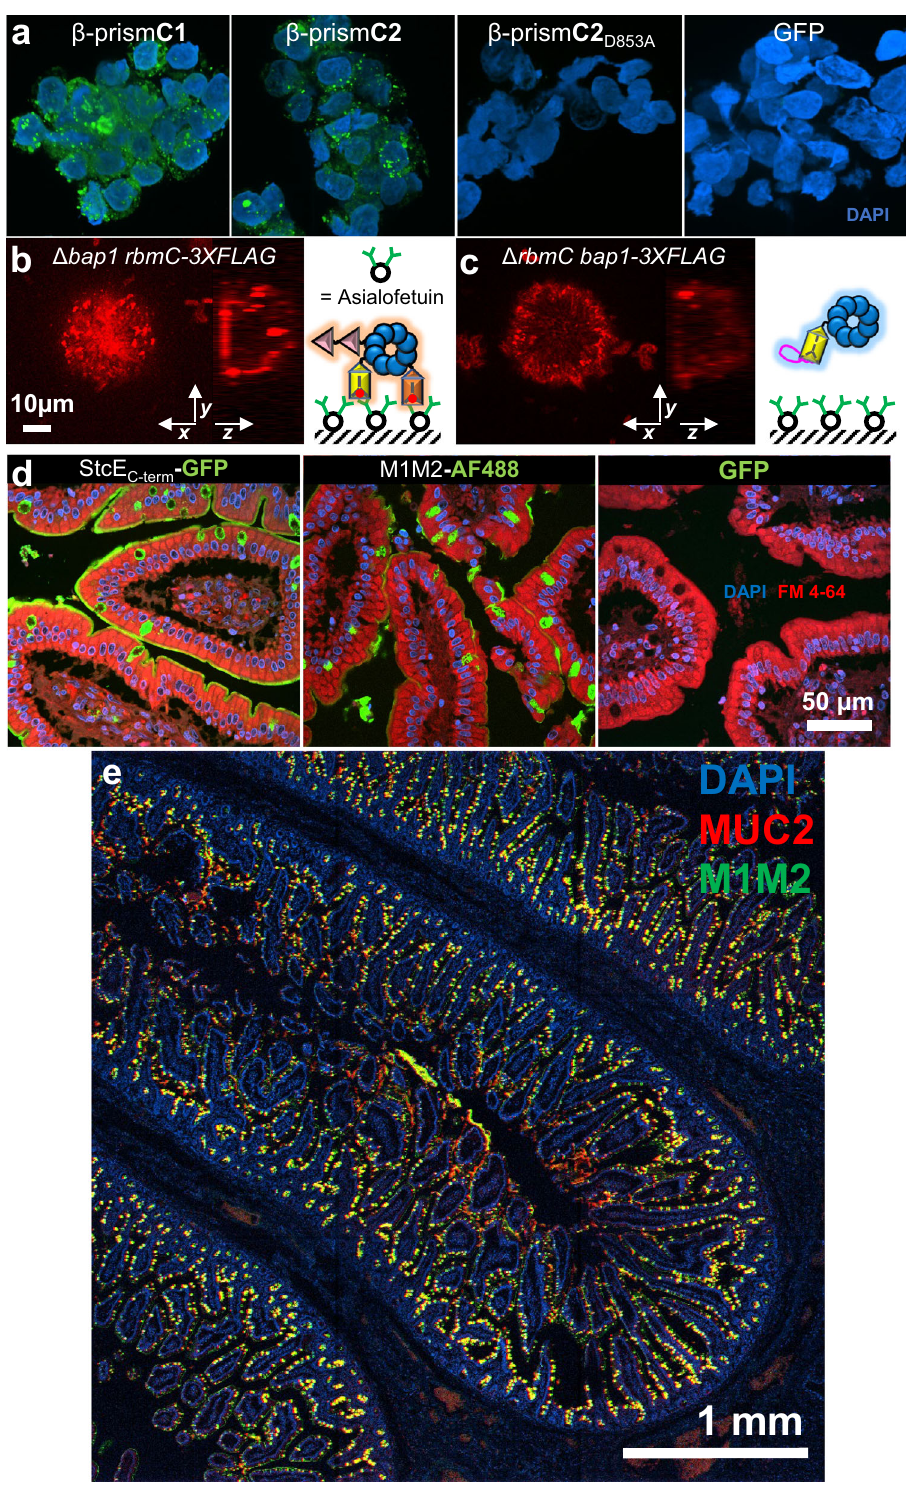
Fig. 4 | RbmC targets host cell surfaces via N-glycan and mucin-binding domains. a Merged z-stack of confocal images of DAPI-stained Caco-2 cells incu- bated with 1 µ M puri fi ed and GFP-tagged β -prism domains. The total size of each image is 80×80×32.5 µ m. b , c In situ immunostaining of RbmC ( b ) or Bap1 ( c ) in bio fi lms formed on an asialofetuin-coated glass surface. Shown on the right is the corresponding schematic representation of each protein ’ s interaction with an